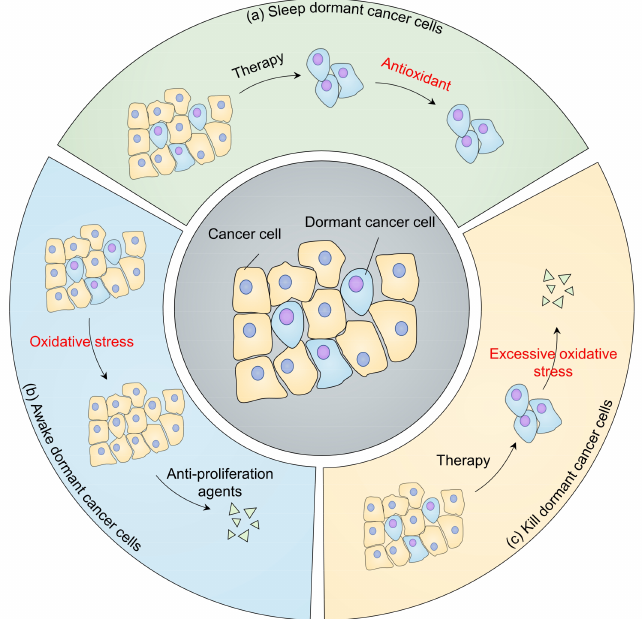
Figure 4. Strategies targeting dormancy from a redox perspective. ( a ) Keep dormant cancer cells asleep. After cancer therapy, dormant cancer cells may remain viable and remain at low redox levels. Antioxidant treatment may prevent dormant cancer cells from reactivating; ( b ) Awaken dormant cancer cells. Oxidants are used to reawaken dormant cancer cells, thus sensitizing them to anti-proliferation agents; ( c ) Kill dormant cancer cells. Oxidative phosphorylation inhibitors, autophagy inhibitors, and ferroptosis inducers can be used to eliminate dormant cancer